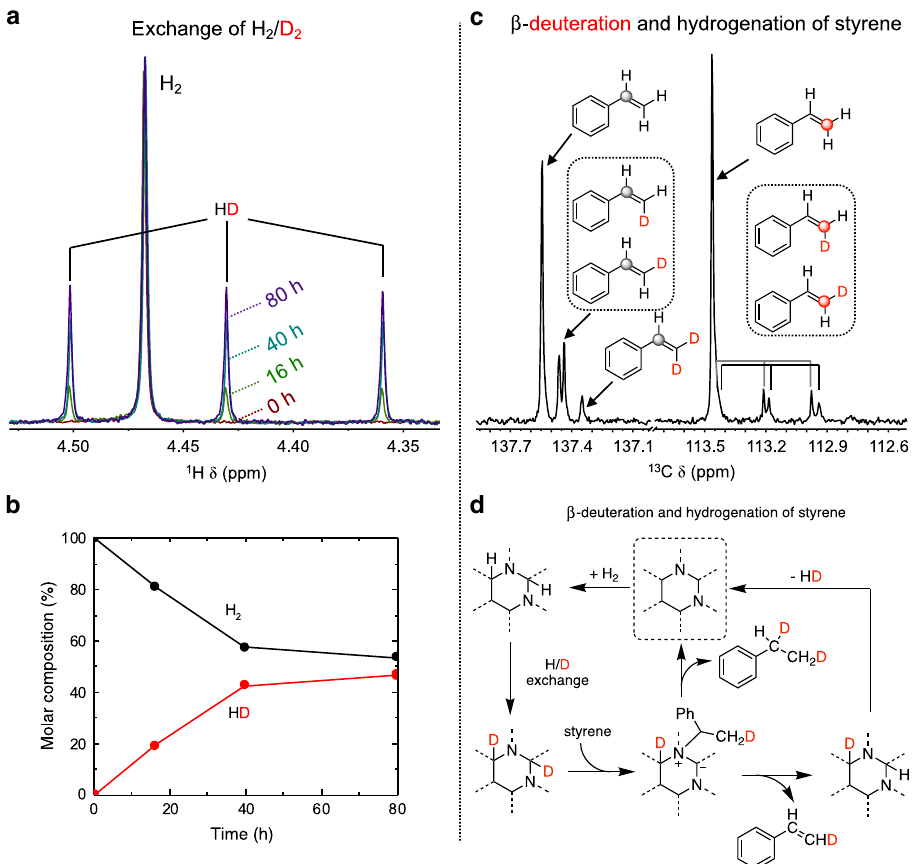
Fig. 5 Mechanistic studies for the understanding of the active site in NACs. a 1 H NMR spectra dissolved gas from the headspace in benzene- d 6 with after H 2 /D 2 exchange catalyzed by NAC-800, showing the formation of gas HD at 0 (magenta), 16 (green), 40 (cyan), and 80 h (purple). All spectra are normalized to H 2 signals. b The molar composition of H 2 and HD over 80 h. Reaction conditions: NAC-800 (25.0 mg), decane (1.50 mL), 230 °C, D 2 (10 bar), and H 2 (10 bar). c 13 C NMR spectrum of ole fi nic carbons in residual styrene after hydrogenation in 2-PrOH- d 8 with H 2 over NAC-800 (gray and red circles indicate styrene C α and C β , respectively). Reaction conditions: 56-mmol L − 1 styrene in 2-PrOH- d 8 (1.50 mL), 230 °C, 20-bar H 2 , 4 h. d Proposed mechanism of β -selective deuteration and hydrogenation of styrene over